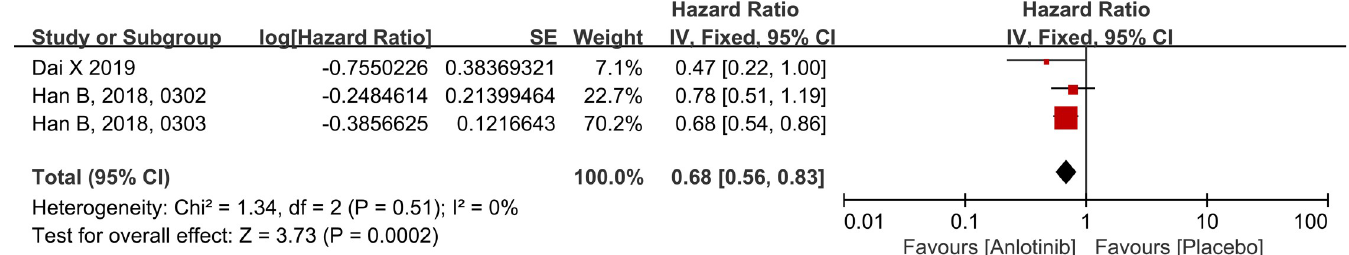
Fig 4. Forest plot comparing the OS between the anlotinib and placebo groups with advanced NSCLC. The red squares represent the HR of a study, and the black line their confidence intervals. The black diamond represent the pooled HR and its confidence interval.